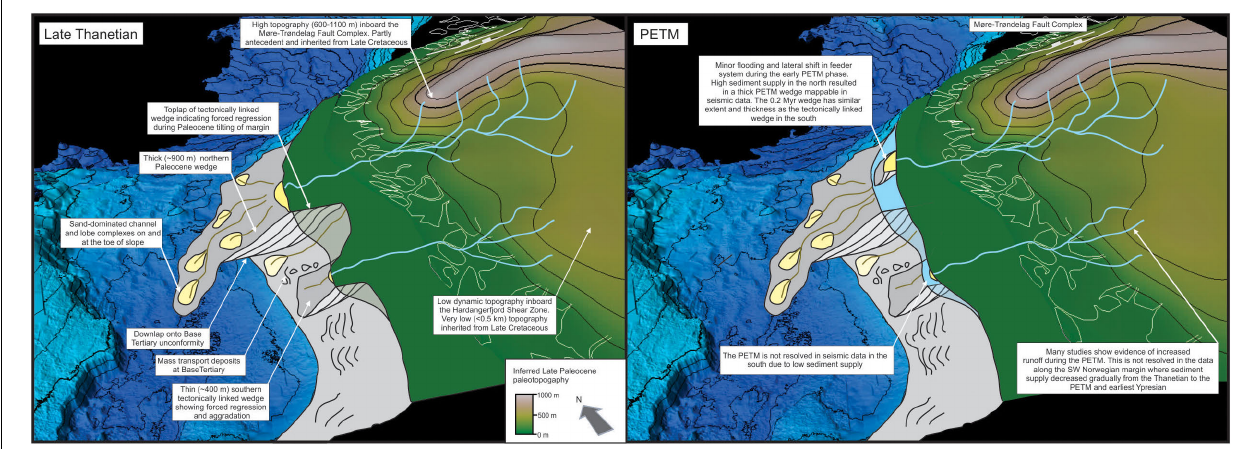
FIGURE 11 | Cartoon showing the inferred topographic and depositional situation in the Late Paleocene and during the PETM. The lower blue surface is the Base Tertiary unconformity. Two tectonically linked wedges prograde into the basin, but the areal extent, internal seismic stratigraphic geometries and thickness depend on along-strike variability in inherited Cretaceous topography and Paleocene dynamic topography. During the 0.2 Myr PETM event, only the northern system had sufficient sediment supply to form a mappable wedge in seismic data. The PETM in the southern area is below seismic resolution. White line shows the present-day coastline. Light blue lines indicate the approximate location of the Paleocene river systems. Cartoon is not to